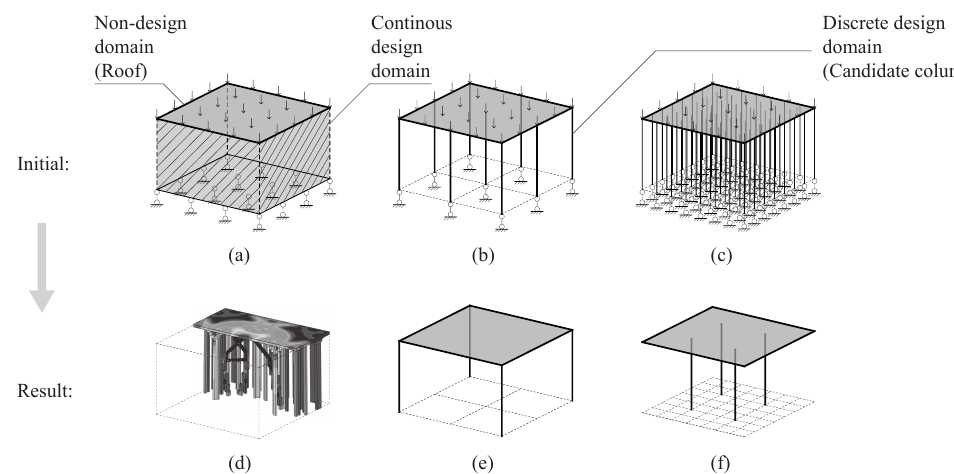
Figure 1. Designing columns under a flat roof using optimization. Subfigures in top row represent initial setup, including flat roof with ( a ) a continuous design domain, ( b ) 3 × 3 discrete design domain, and ( c ) 8 × 8 discrete design domain. Subfigures in second row represent optimization result obtained using ( d ) bidirectional evolutionary structural optimization (BESO) topology method and ( e , f ) proposed new optimization